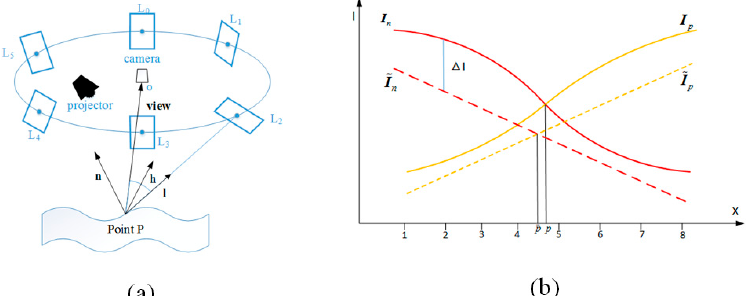
Figure 6. ( a ) Illustration of reflectance model. Apart from incoming light, the intensity is related to the direction of view and the halfway vector h . L 0 ~ L 5 is the number of the area light source; ( b ) Illustration of our proposed method. In and Ip are the original intensity vector of the detected stripe; the improved ones with the modulation resulting from geometry